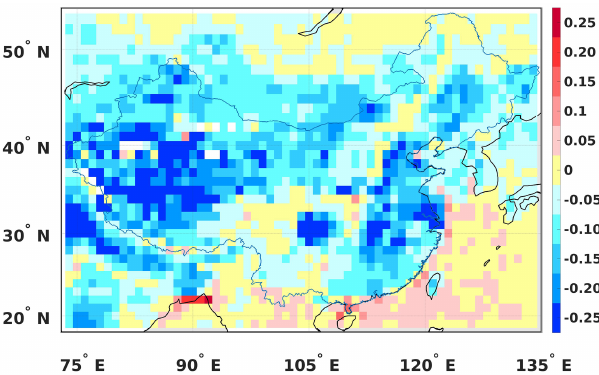
Figure 8. Same as Fig. 7 but for MODIS/Terra C6 merged DTDB AOD data.